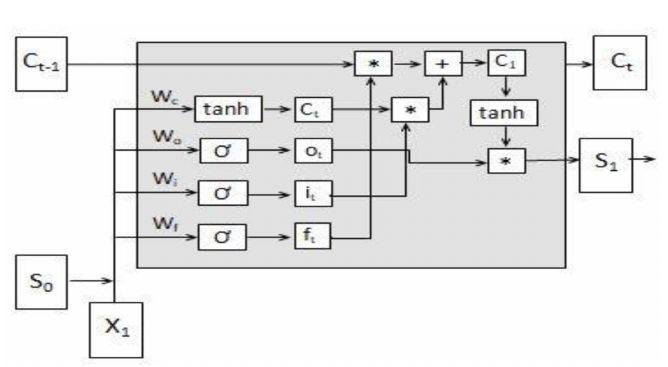
Figure 4. The architecture of Long Short-Term